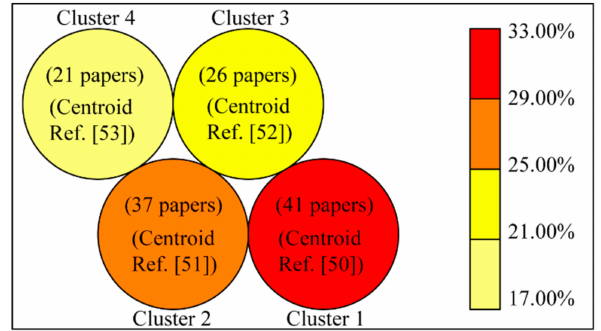
Figure 8. Number of papers in each